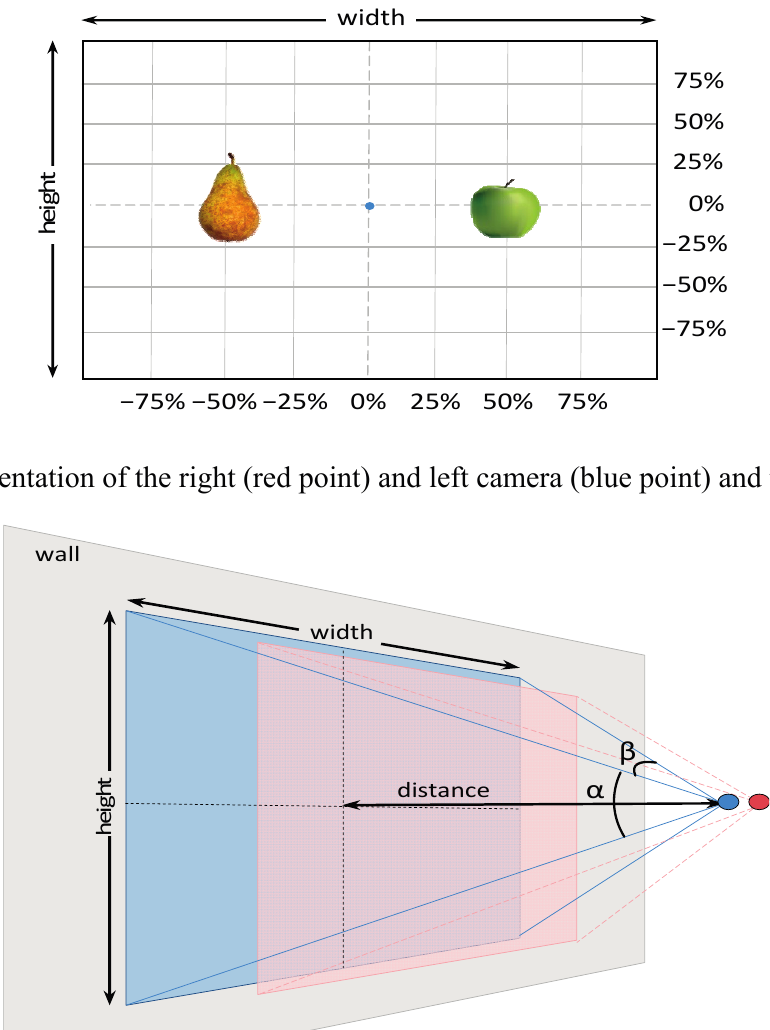
Figure 7. Relative grid definition and targets used in the experimental setup.